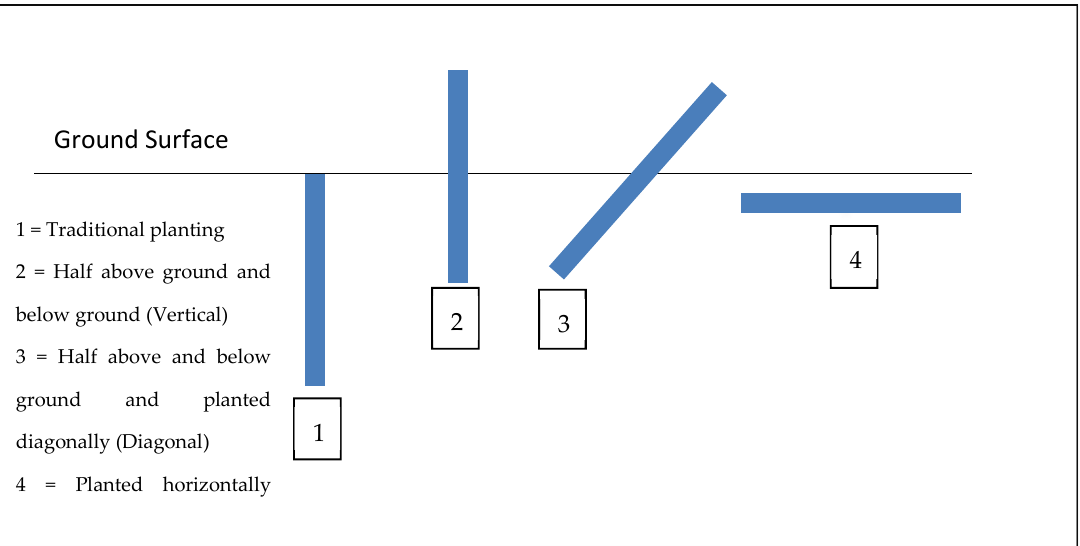
Figure 1. Treatment orientations below and above ground level.